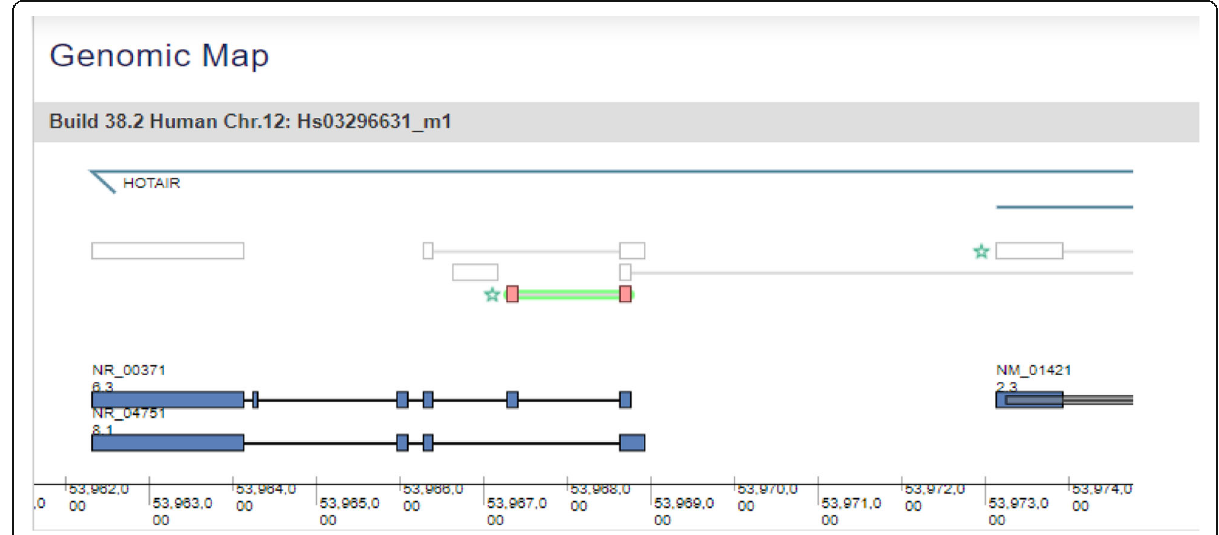
Fig. 1 HOTAIR genomic map (https://www.thermofisher.com/taqman-gene-expression) [14]